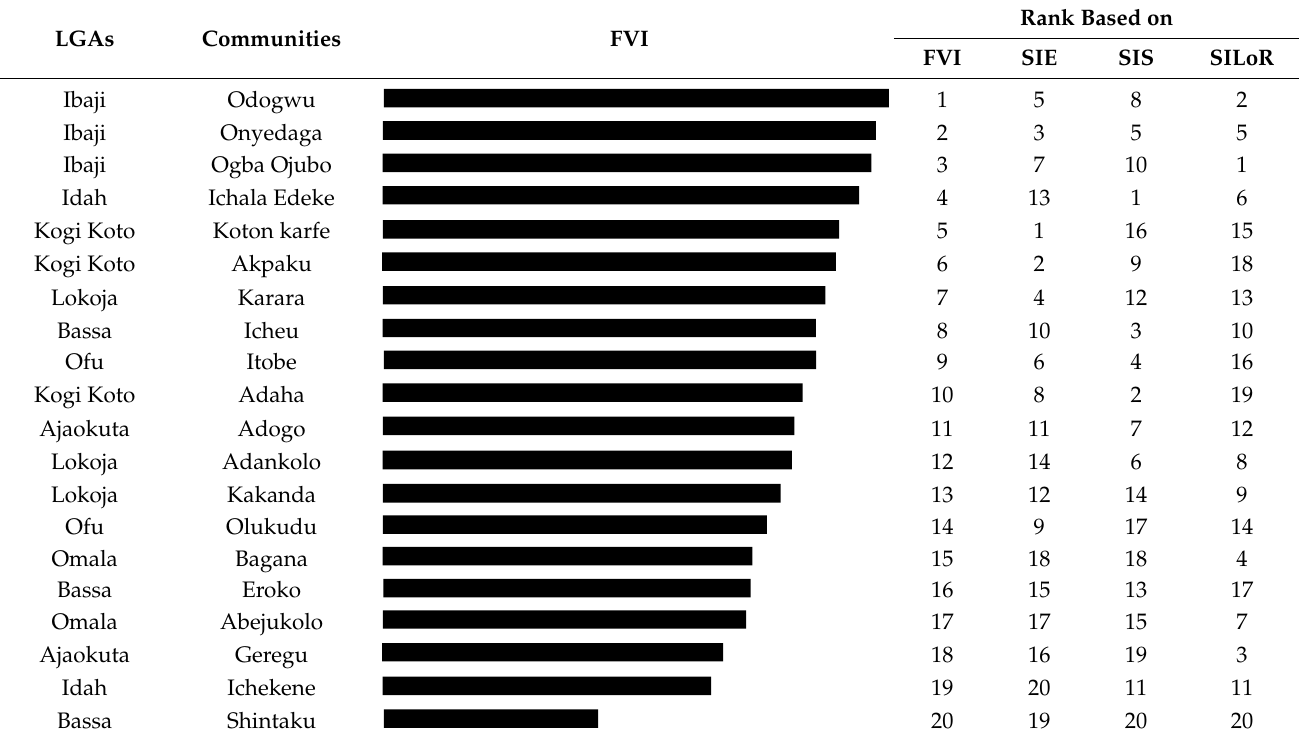
Table 5. Ranking of the flood-prone communities based on their FVI values.